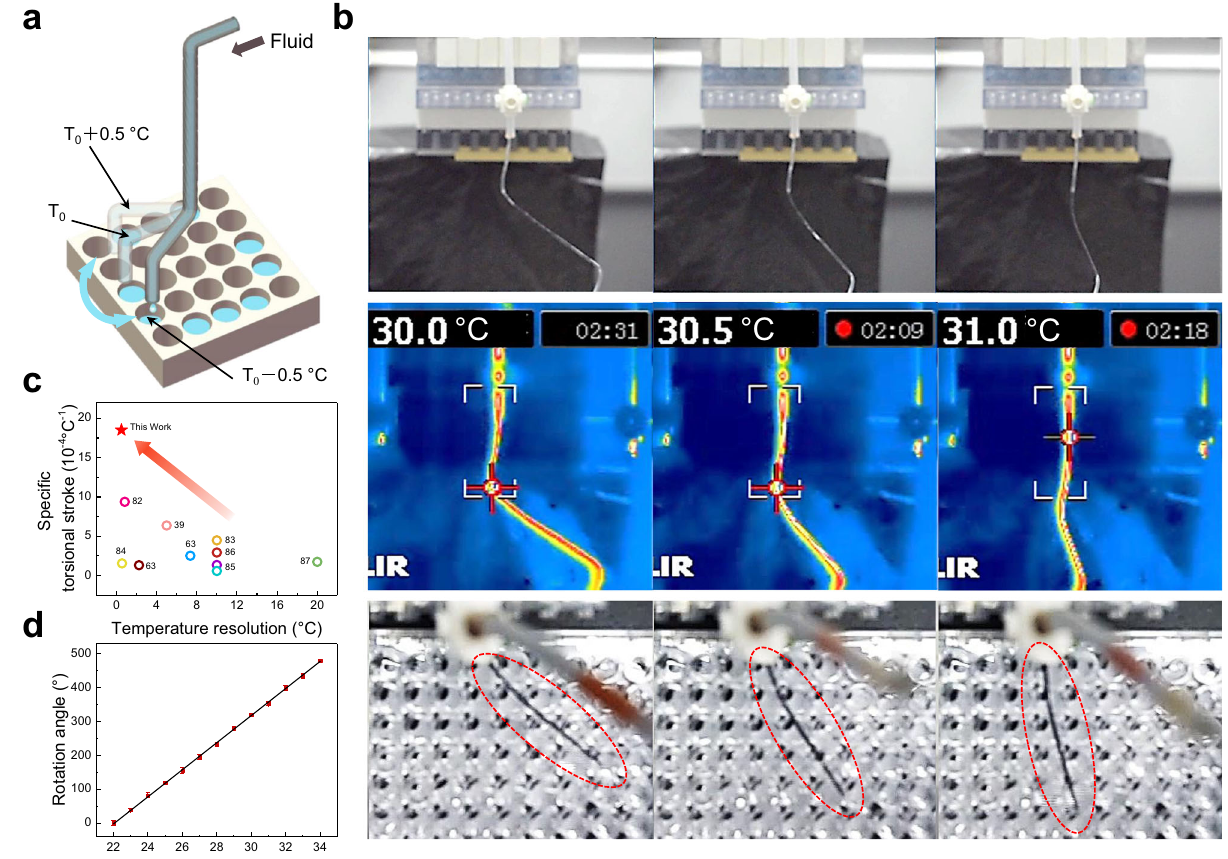
Fig. 5 Micro fl uidic sensing and manipulation by PEHF 580-990 actuators. a Schematic of the micro fl uidic sensing and manipulation device. b Optical images of PEHF 580-990 actuators for sensing the liquid temperature and sorting the liquid into the desired vessels. c Comparison of the temperature resolution and speci fi c torsional stroke of PEHF 580-990 with those in previous studies. The speci fi c torsional stroke is de fi ned as Δ T /( T · Δ θ ), where Δ T denotes the thermally driven torsional rotation, T denotes the twist density, and Δ θ is the temperature change. The temperature resolution is the minimum temperature change used to trigger torsional actuation. d Torsional angle as a function of water